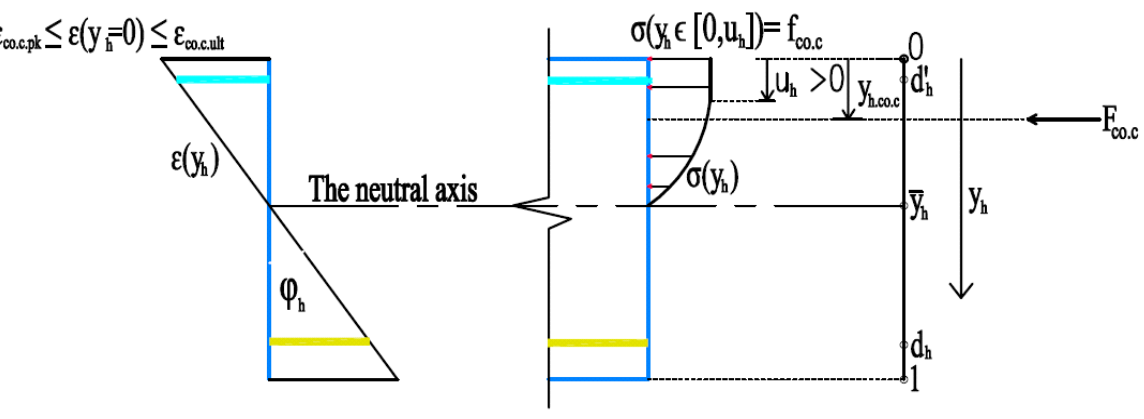
(cid:16) (cid:17) ε ( y = 0 ) > ε co.c.pk